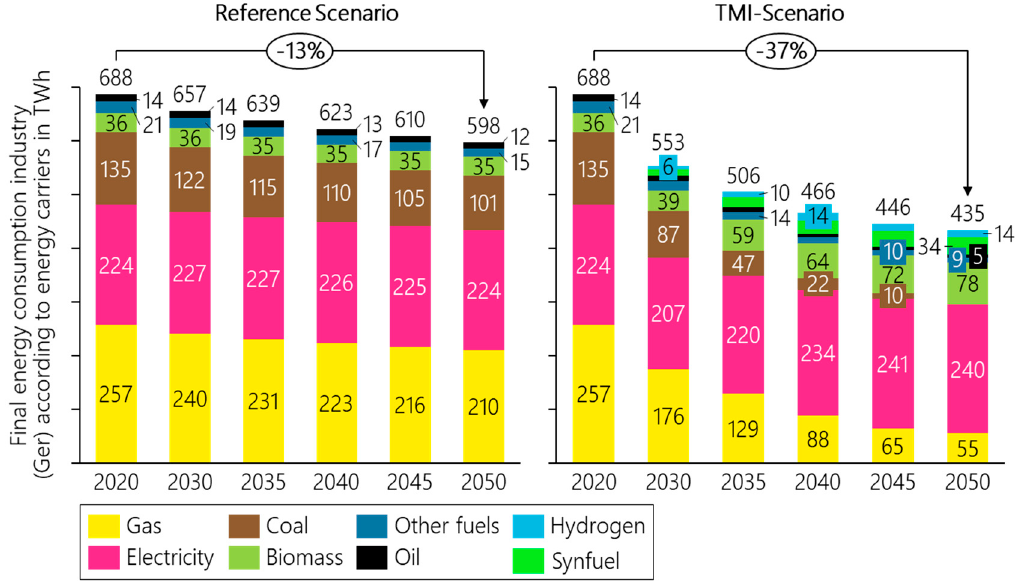
Figure A1. Energy consumption by energy carrier in the Reference (left) and TMI scenarios between 2020 and 2050.